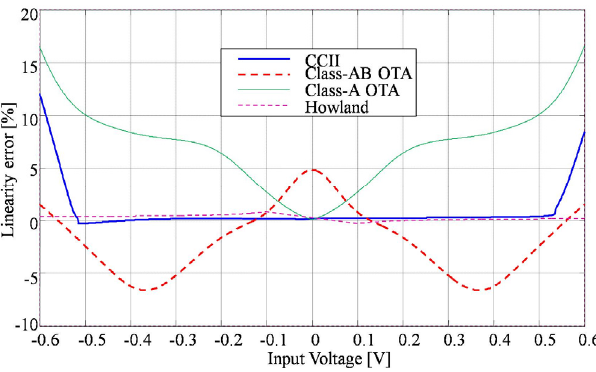
Fig.5: Linearity error response of the current source over the input voltage range -0.6 to +0.6 V, using a resistive load of 1 k Ω .